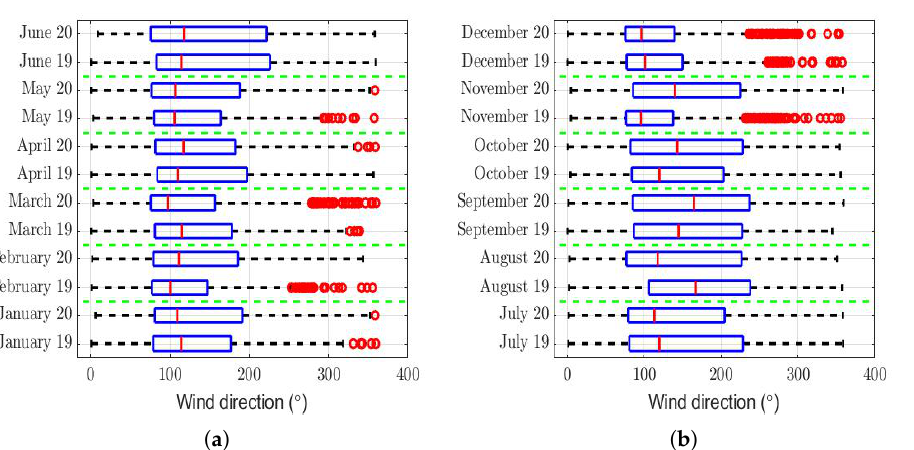
Figure 8. Box plot of the wind direction ( ◦ ): 2019 vs. 2020. The red circles represent the outliers.